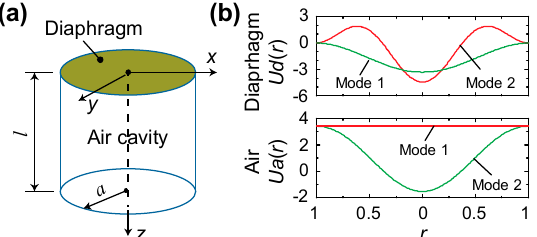
Figure 1. Introduction of the studied problem. ( a ) Schematic of a circular clamped diaphragm backed by a cylindrical air cavity, which has a rigid sidewall and bottom. ( b ) The mode shapes of the first two axisymmetric modes of the diaphragm (top) and air cavity (bottom).